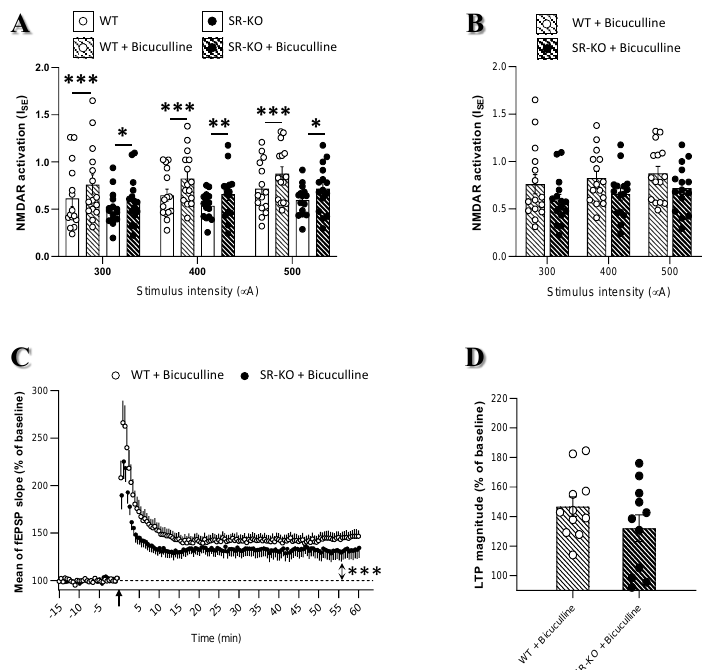
Figure 5. Serine racemase deletion changes the excitation/inhibition balance in CA1 hippocampal networks. ( A ). Effects of the GABA A receptor antagonist bicuculline (10 µM) on I SE of NMDAR- mediated fEPSPs. Increase in NMDAR activation occurred in both experimental groups at all intensities but the significance was much lower in SR-KO ( n = 15 slices) than in WT mice ( n = 15 slices) (* p < 0.05, ** p < 0.001, *** p < 0.0001 for paired t -tests). ( B ). Comparison I SE of NMDAR-mediated synaptic potentials in WT and SR-KO mice after blockade of the GABA A receptor activity. ( C ). Time-course of LTP expression in WT ( n = 15 slices) and SR-KO ( n = 15 slices) mice in the presence of bicuculline (10 µ M) (*** p < 0.0001 for one sample t -test vs. baseline for each experimental group). ( D ). Comparison of mean LTP magnitude calculated for the last 15 min in WT and SR-KO